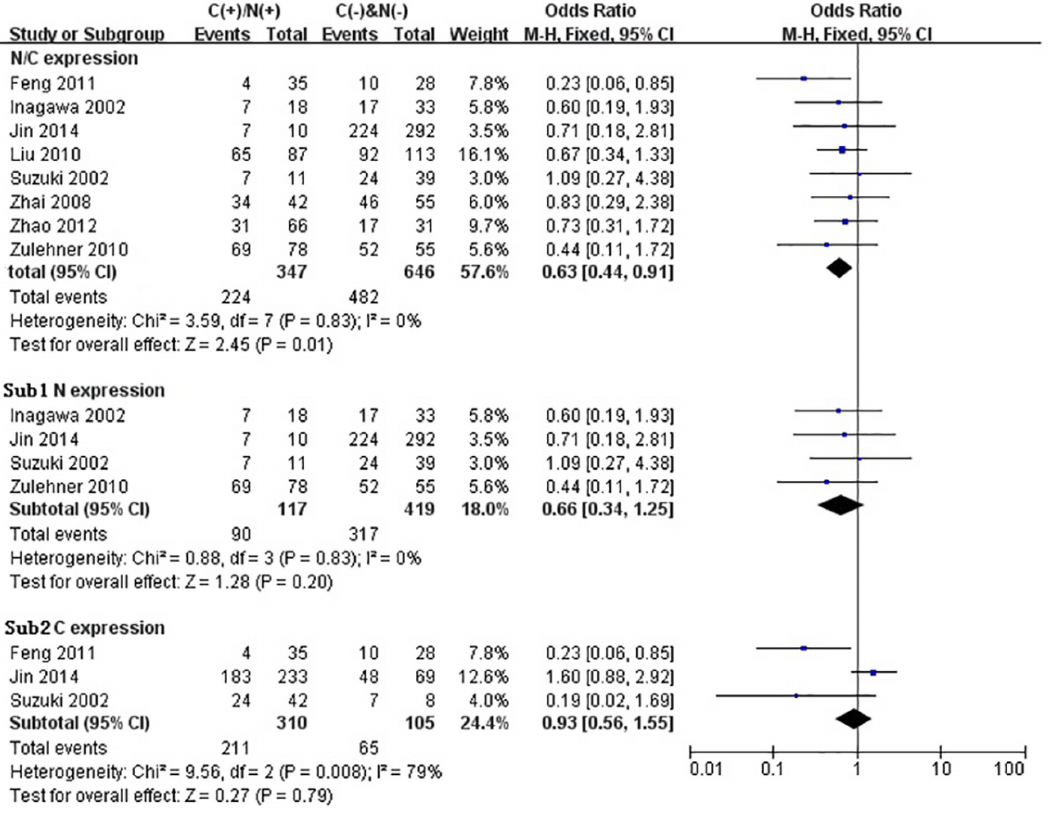
Figure 4. Forest plot of odds ratio for the association of b -catenin expression in cytoplasm and/or nucleus with metastasis by subgroup analysis. Sub1: in cytoplasm alone. Sub2: b -catenin expression in nucleus